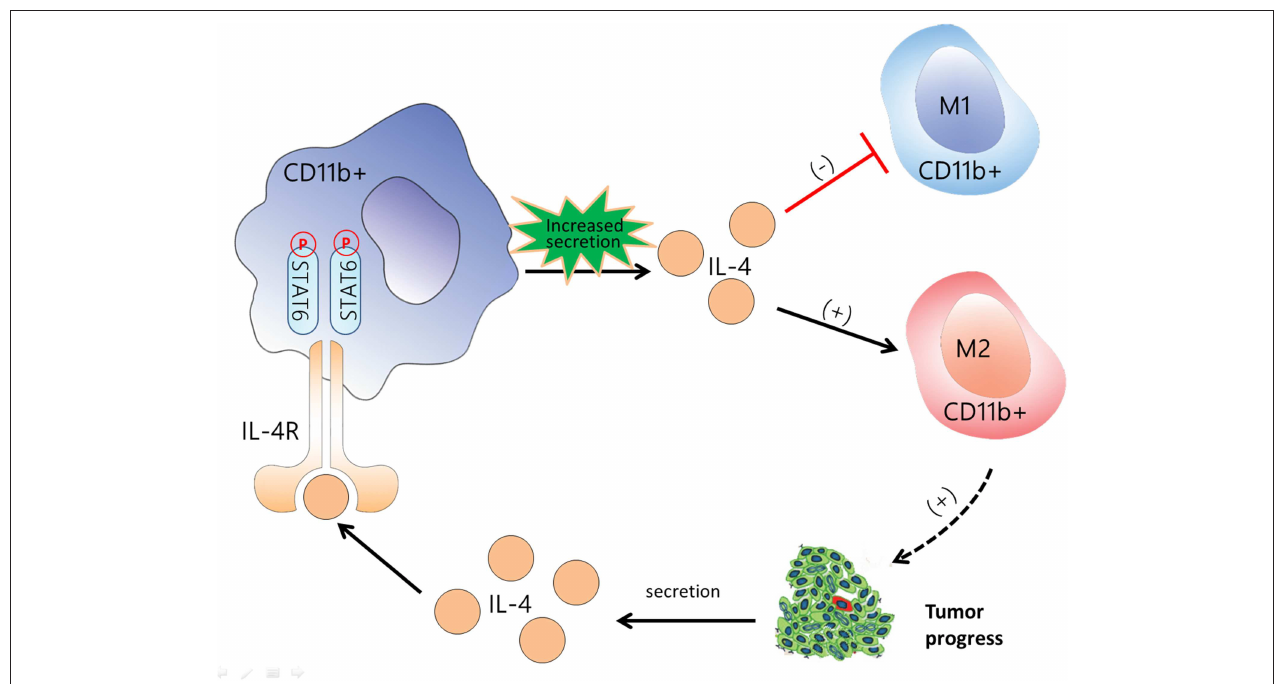
FIGURE 9 | Flow diagram illustrating the main idea of this study. Activation of signal transducer and activator of transcription 6 (STAT6) signaling in CD11b + cells increases the secretion of IL-4, promotes differentiation to M2 myeloid cell, and suppresses M1 polarization. M2 myeloid cells promote cancer cell proliferation and interleukin (IL)-4 secretion in tumor cells, which creates a positive feedback loop. IL-4 binding to the IL-4 receptor begins the next positive feedback loop. The black arrow indicates the promotive effect, and the red line indicates the suppressive effect. CD11b + cells are represented by the red cells among the tumor